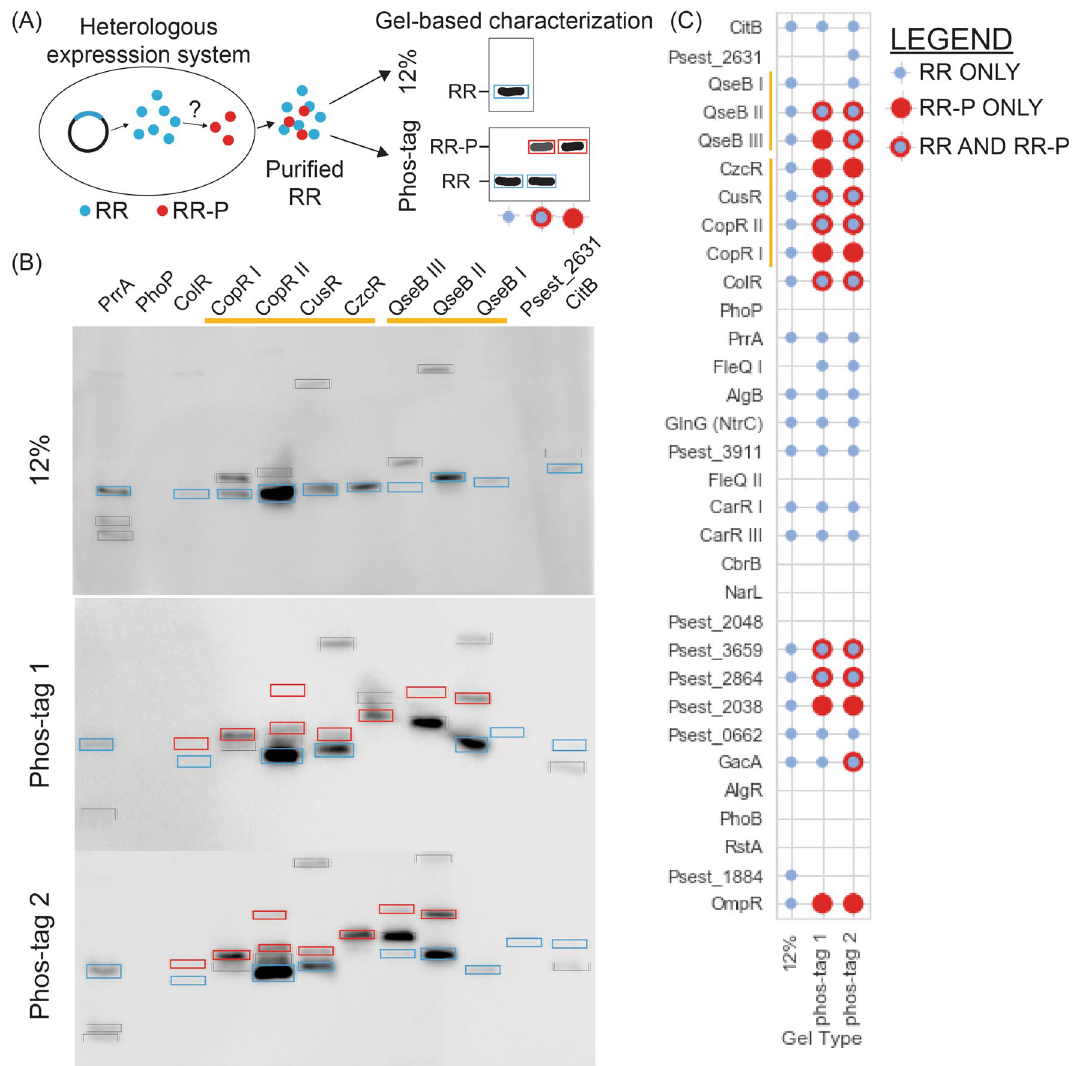
Figure 1. Systematic characterization of phosphorylation state of heterologously expressed Response Regulators (RRs) ( A ) Methodological overview used to systematically characterize RR phosphorylation state. RR is heterologously expressed in E. coli , purified, and characterized on 12% or phos-tag gels. Purified RR will not shift in a 12% gel, however, can exhibit three possible patterns in phos-tag gel: unphosphorylated (no shift), partially phosphorylated (1 unshifted band and 1 or more shifted bands), or fully phosphorylated (1 or more shifted bands). ( B ) 12% and phos-tag gels of select RRs from Pseudomonas stutzeri RCH2. Blue boxes around unphosphorylated protein, red boxes around shifted phosphorylate proteins in phos-tag gels, black boxes around ambiguous bands that could be the result of co-purified background proteins or protein dimers. Paralogous RRs referenced in text are indicated by yellow bars. ( C ) Graphical qualification of bands in 12% or phos-tag gels for each RR characterized from P. stutzeri RCH2. Blue circles indicate presence of non- phosphorylated bands, red circles indicate presence of shifted, phosphorylated bands, red circles overlaid with blue circles indicate presence of both non-phosphorylated bands and phosphorylated bands. Paralogous RRs referenced in text are indicated by yellow